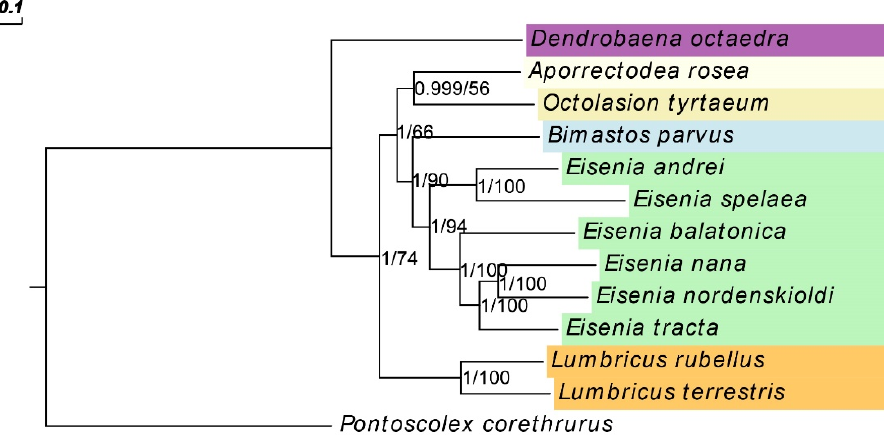
Figure 2. Mitogenomic phylogenetic tree of 12 Lumbricidae species and an outgroup ( P. corethrurus ) based on 13 PCGs using the BI method and ML method. Different colors indicate different genera. Numbers at nodes are statistical support values for BI (posterior probabilities)/ML (bootstrap values).